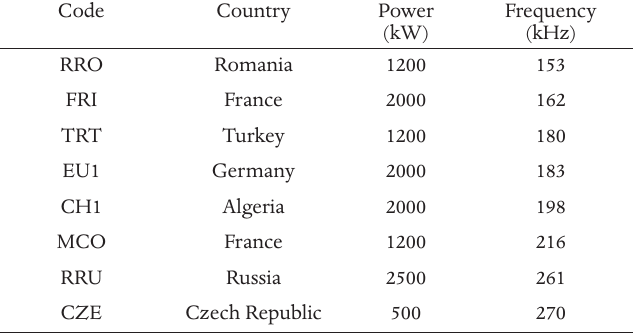
Table 1. Particularities of the LF transmitters of the European